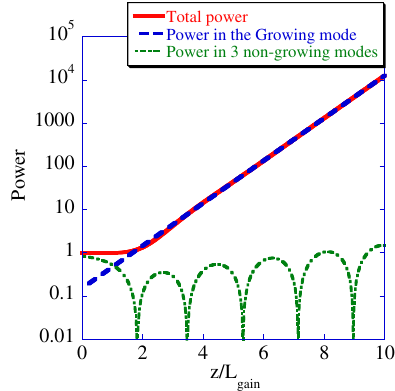
FIG. 1. Evolution of FEL optical power along the FEL: solid line (red)—the total power in all four eigenmodes; dashed line (blue)—the power in the growing eigenmode; dotted line (green)—remaining power in three nongrowing modes. Horizontal axis—length along the FEL in the units of gain length. Vertical axis in log-scale—optical power in units of the input